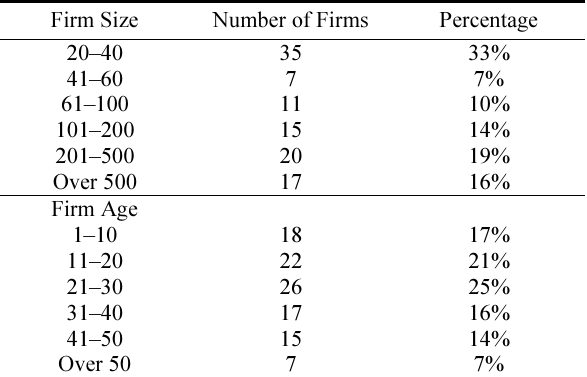
Table 2. Demographic profile of participating